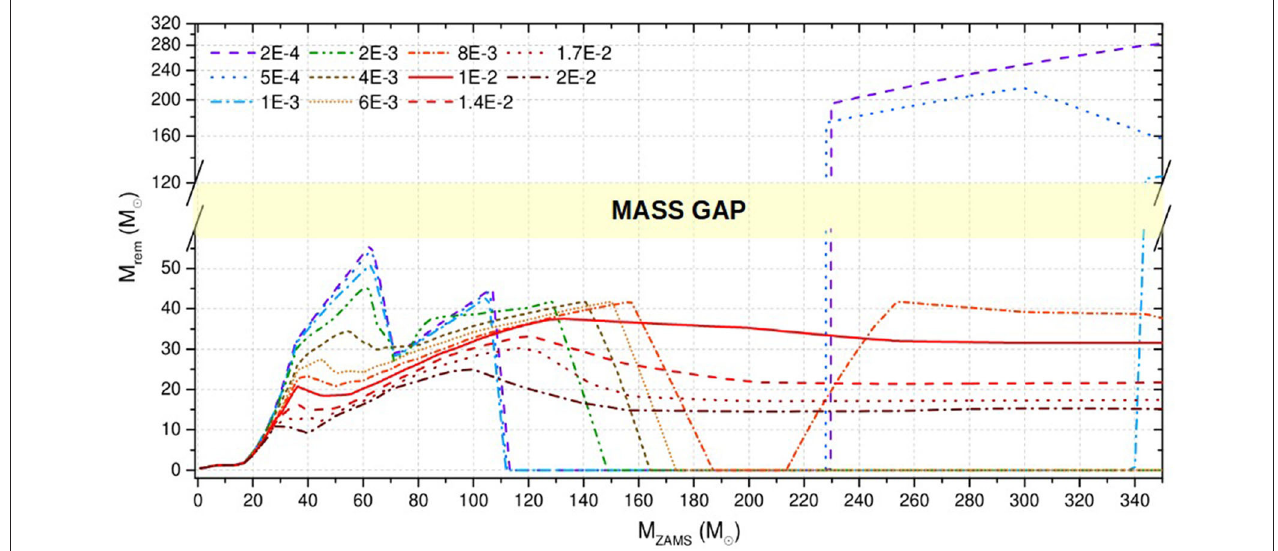
FIGURE 1 | Predicted compact object mass ( M rem ) as a function of the zero-age main-sequence (ZAMS) mass of the progenitor star ( M ZAMS ) for 11 different metallicities, ranging from Z = 2 × 10 − 4 to Z = 2 × 10 − 2 , as shown in the legend. The yellow area highlights the pair-instability mass gap. These models are obtained with the SEVN population synthesis code ( Spera et al., 2019), using PARSEC evolutionary tracks (Bressan et al., 2012) and the delayed model from Fryer et al. (2012). See Spera and Mapelli (2017) for